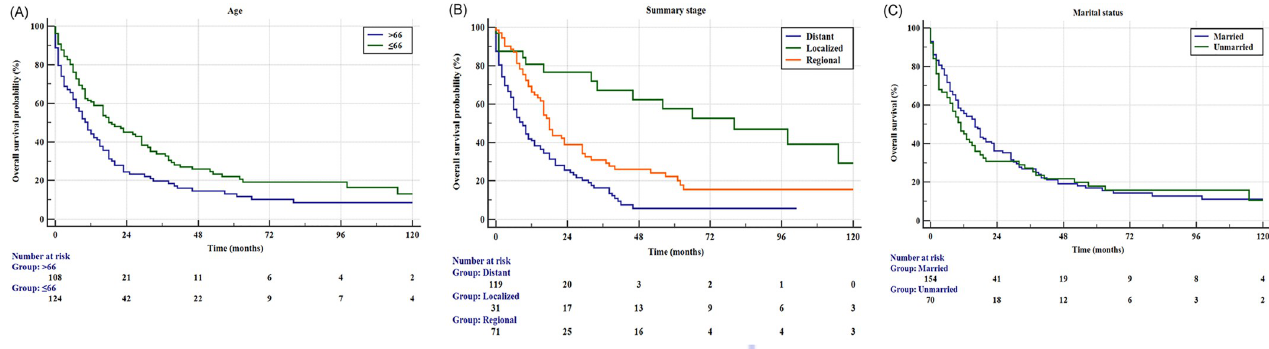
Fig 2. (A) Kaplan–Meier estimated overall survival (OS) for patients with pancreatic acinar cell carcinoma (ACC) in terms of age (p = 0.003), (B) Kaplan– Meier estimated OS for patients with pancreatic ACC in terms of summary stage (p < 0.001 for both); (C). Kaplan–Meier estimated OS for patients with pancreatic ACC in terms of marital status (p =